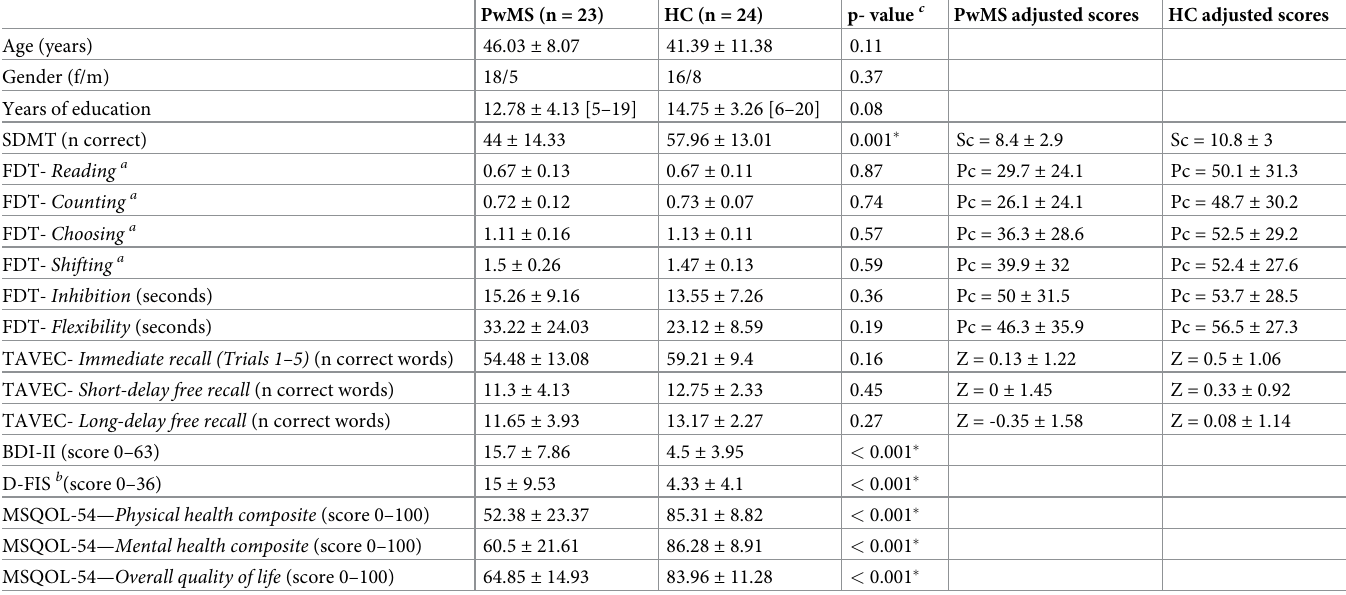
Table 1. Comparison of demographic, neuropsychological and symptomatic features of pwMS and HC (mean ± SD). PwMS (n =